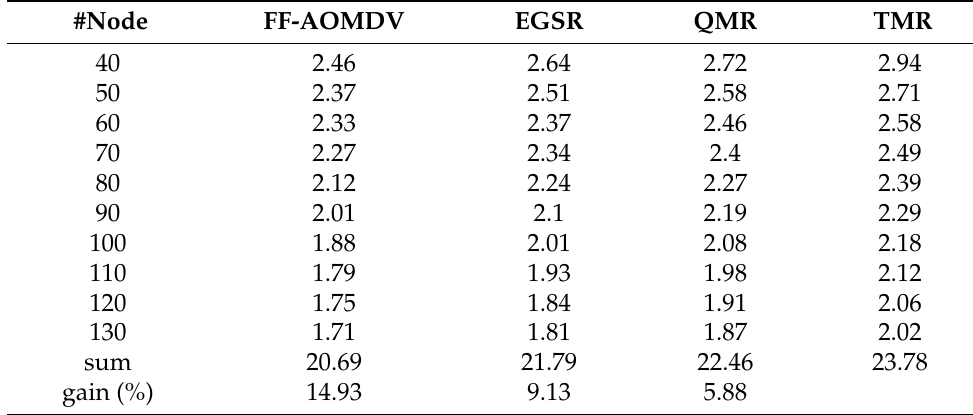
Table 3. Number of nodes vs. throughput of Figure 14.